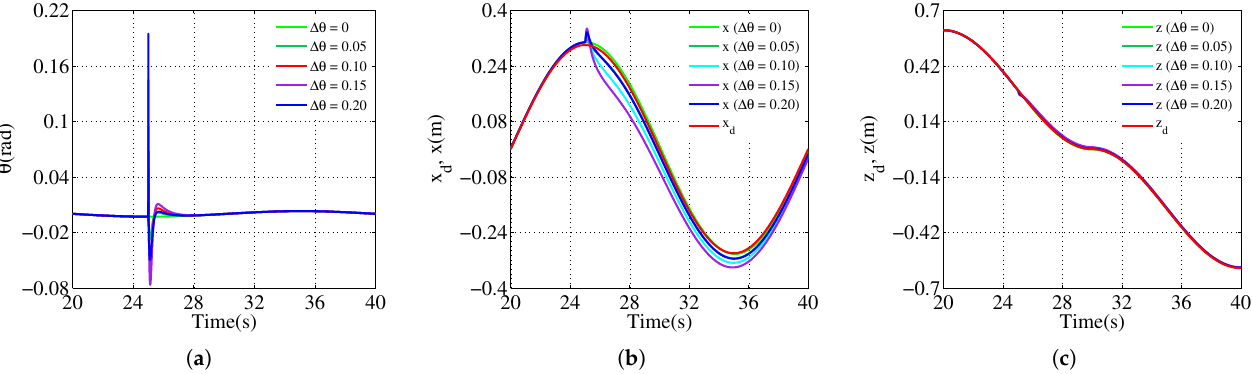
Figure 14. The simulation tests when ∆ θ = 0,0.05,0.10,0.15, and 0.20. ( a ) The θ ; ( b ) the x d and x ; and ( c ) the z d and z